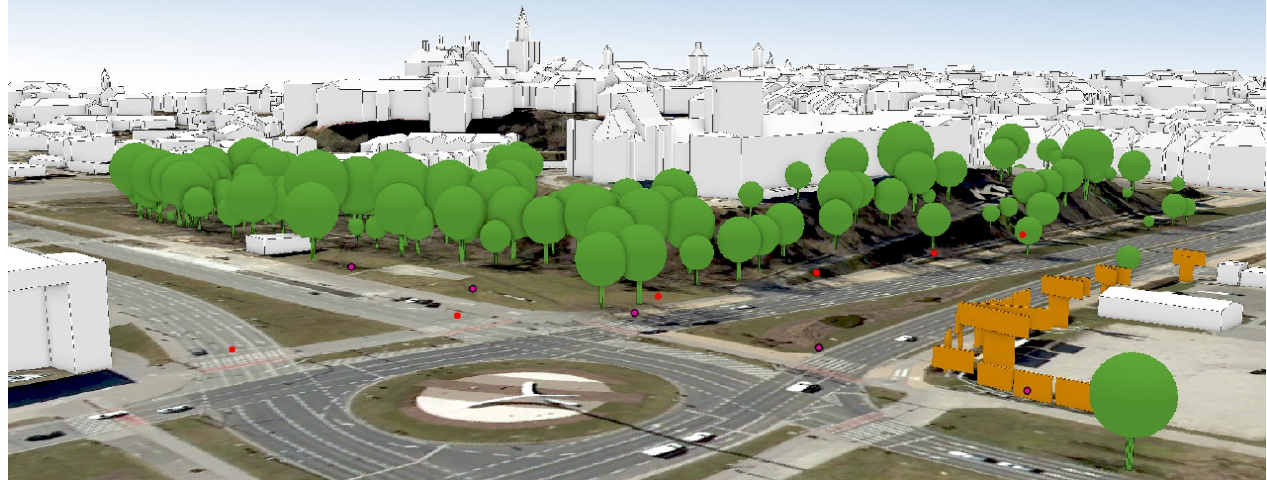
Figure 7. The visualization of the 3D city model (area B example). The red and purple dots are the measurement points, the OOHb infrastructure is presented as orange 3D symbols.